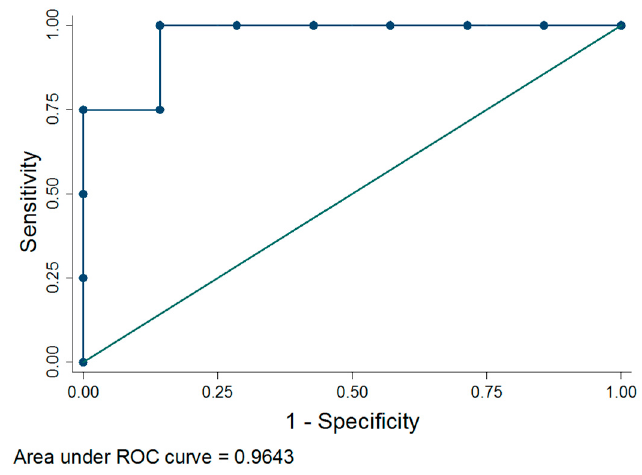
Figure 2. Receiver operating characteristic (ROC) curve of Legionella water concentration to discriminate between presence and absence of Legionella in the air by at least one culture-based method.